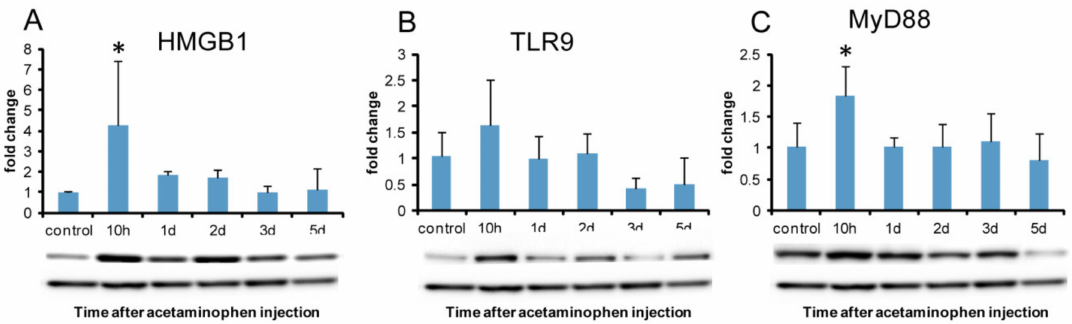
Figure 11. Western blotting for HMGB1, TLR9, and MyD88 in APAP-induced rat hepatotoxicity. The expression level of HMGB1 protein significantly increases at hour 10 ( A ). TLR9 protein expression does not show a significant increase; however, it tends to increase at hour 10 ( B ). MyD88 protein expression significantly increases at hour 10 ( E ). A representative band is shown at each examination point ( A , B , and C ). GAPDH was used as the loading control (lower panel). Dunnett’s test; *, significantly di ff erent from controls at p < 0.05. Bar represents mean ± SD. TLR9, toll-like receptor 9; MyD88, Myeloid Di ff erentiation